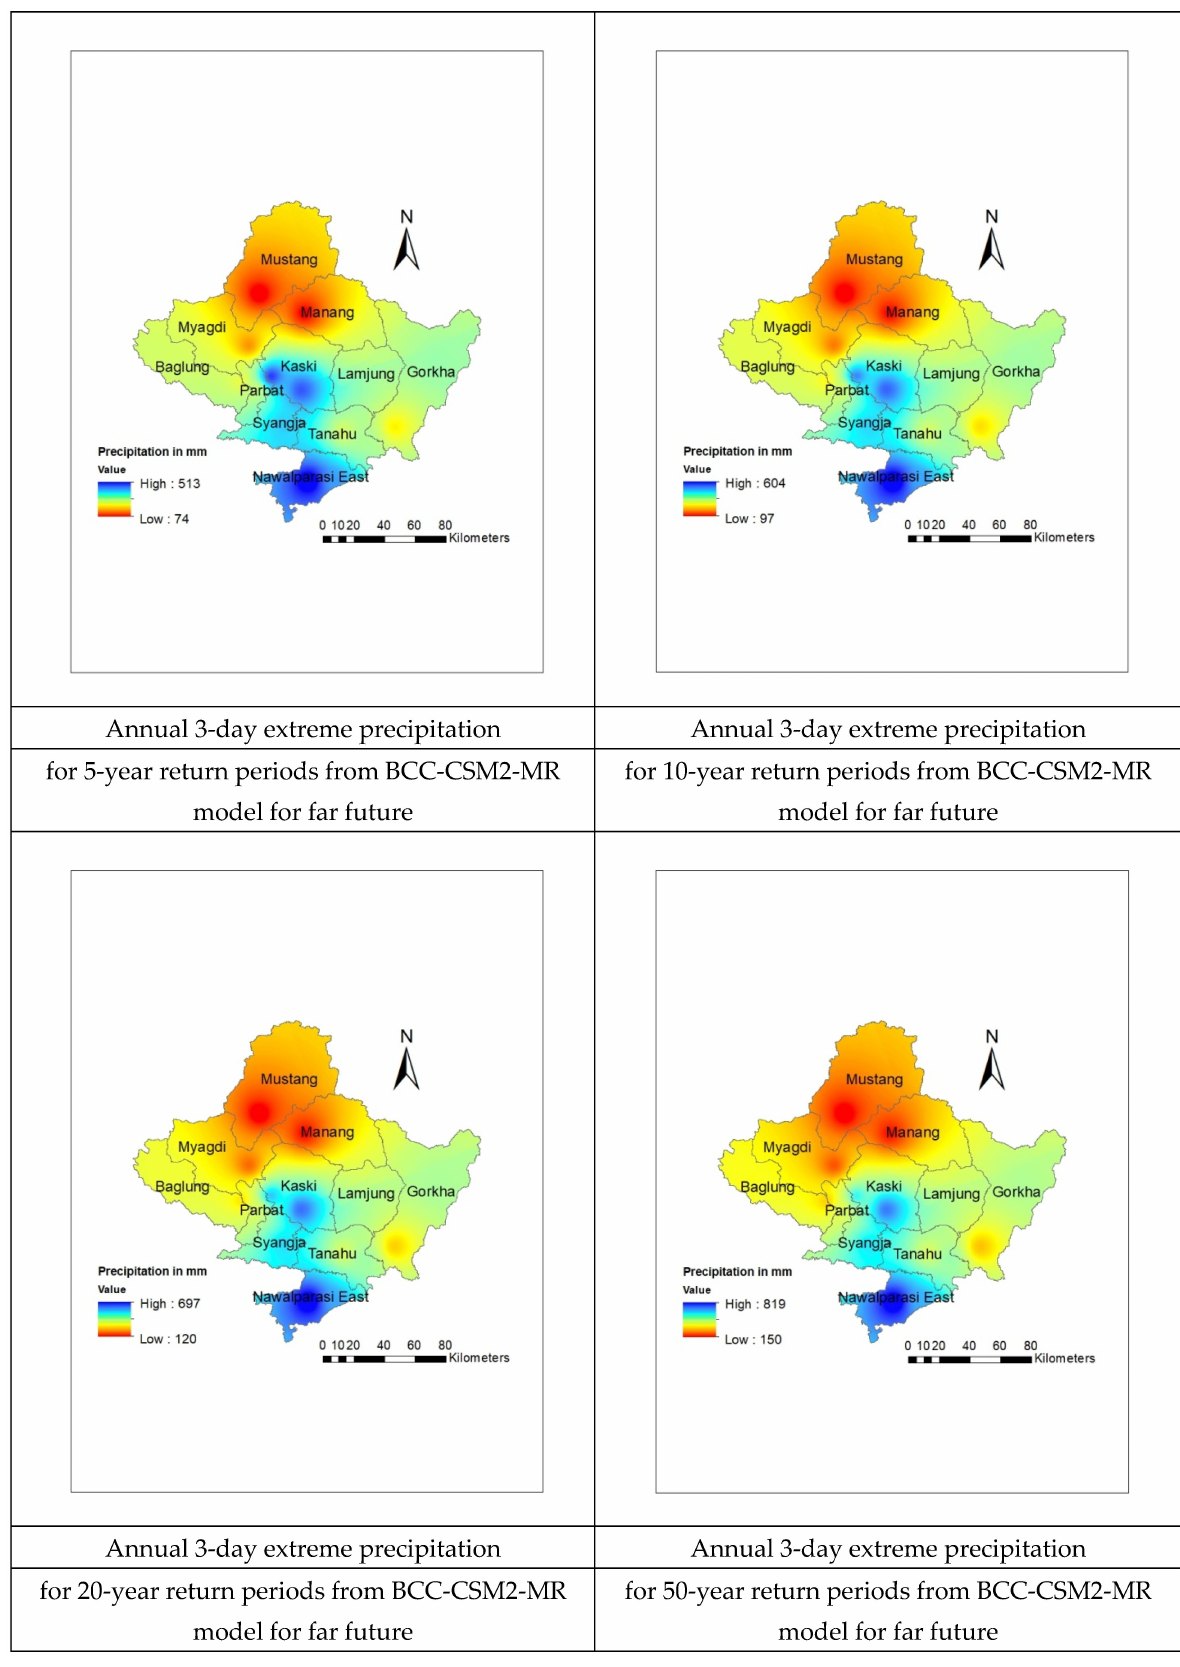
Figure A16. Cont